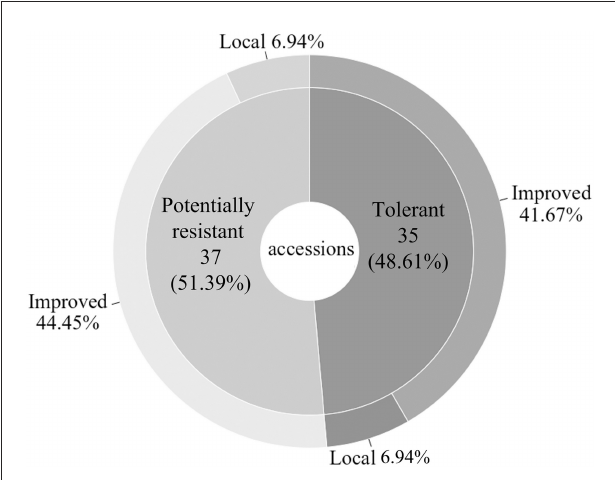
FIGURE4 Proportion of potentially resistant and tolerant cassava accessions found in 610 Côte d’Ivoire cassava germplasm collection maintained at Bouaké and Man